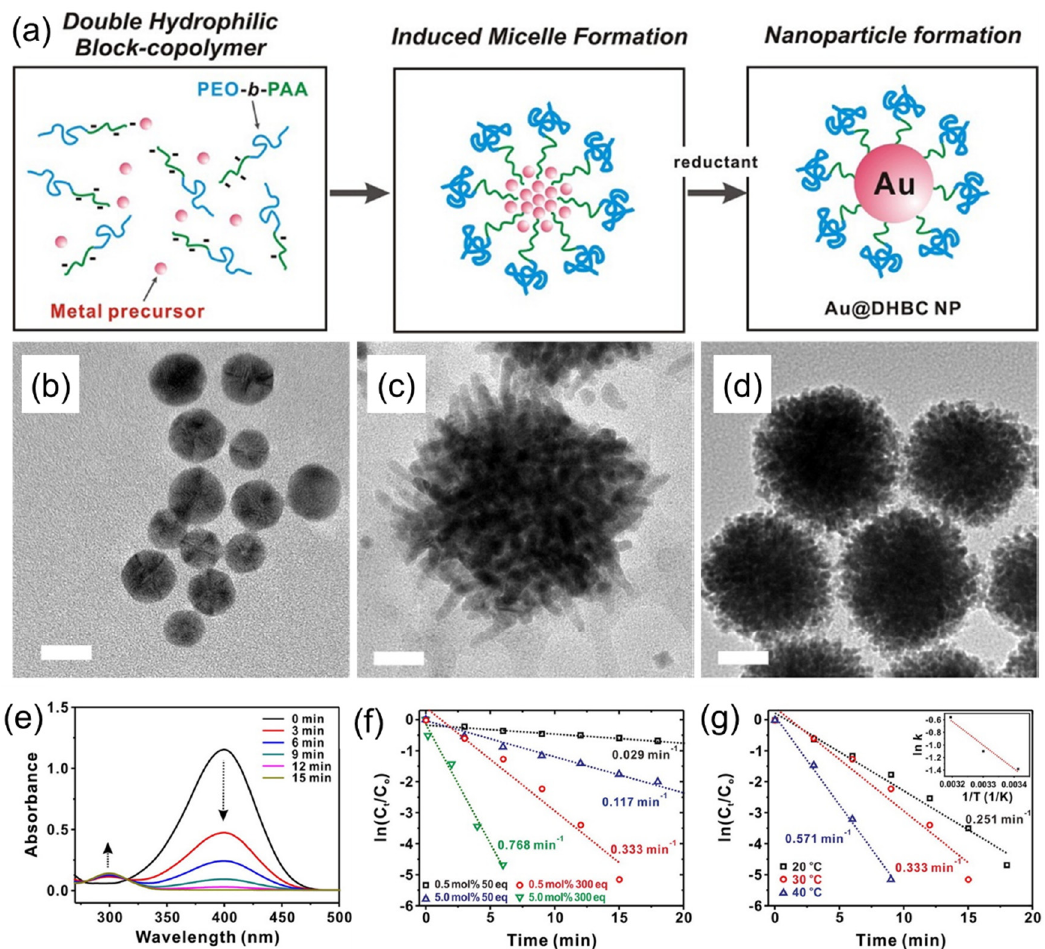
Figure 7. ( a ) Schematics of the synthesis of an Au–DHBC NP through the coordinative bonding between the Au precursor and PEO– b –PAA as a soft template. ( b , c ) TEM images of ( b ) Au–DHBC, ( c ) Pd–DHBC, and ( d ) Pd–DHBC NPs. Scale bars on TEM images correspond to 10 nm ( b ) and 20 nm ( c , d ). ( e ) Time-dependent UV-Vis absorption spectra for the reduction of 4-nitrophenol over an Au–DHBC NP catalyst in aqueous media at 303 K. ( f ) Plot of ln( C t / C 0 ) versus time spectra for the reduction of 4-nitrophenol over the Au–DHBC catalyst under different mol% of catalyst and equivalents of NaBH 4 used, where C 0 and C t are the initial concentration of 4-nitrophenol and 4-nitrophenol concentration at time t , respectively. ( g ) Plot of ln( C t / C 0 ) versus time for the reduction of 4-nitrophenol over Au–DHBC NP catalysts under different temperatures at 0.50 mol% catalyst and 300 equiv of NaBH 4 . The inset on ( g ) shows the corresponding Arrhenius plot. Adapted from [28].